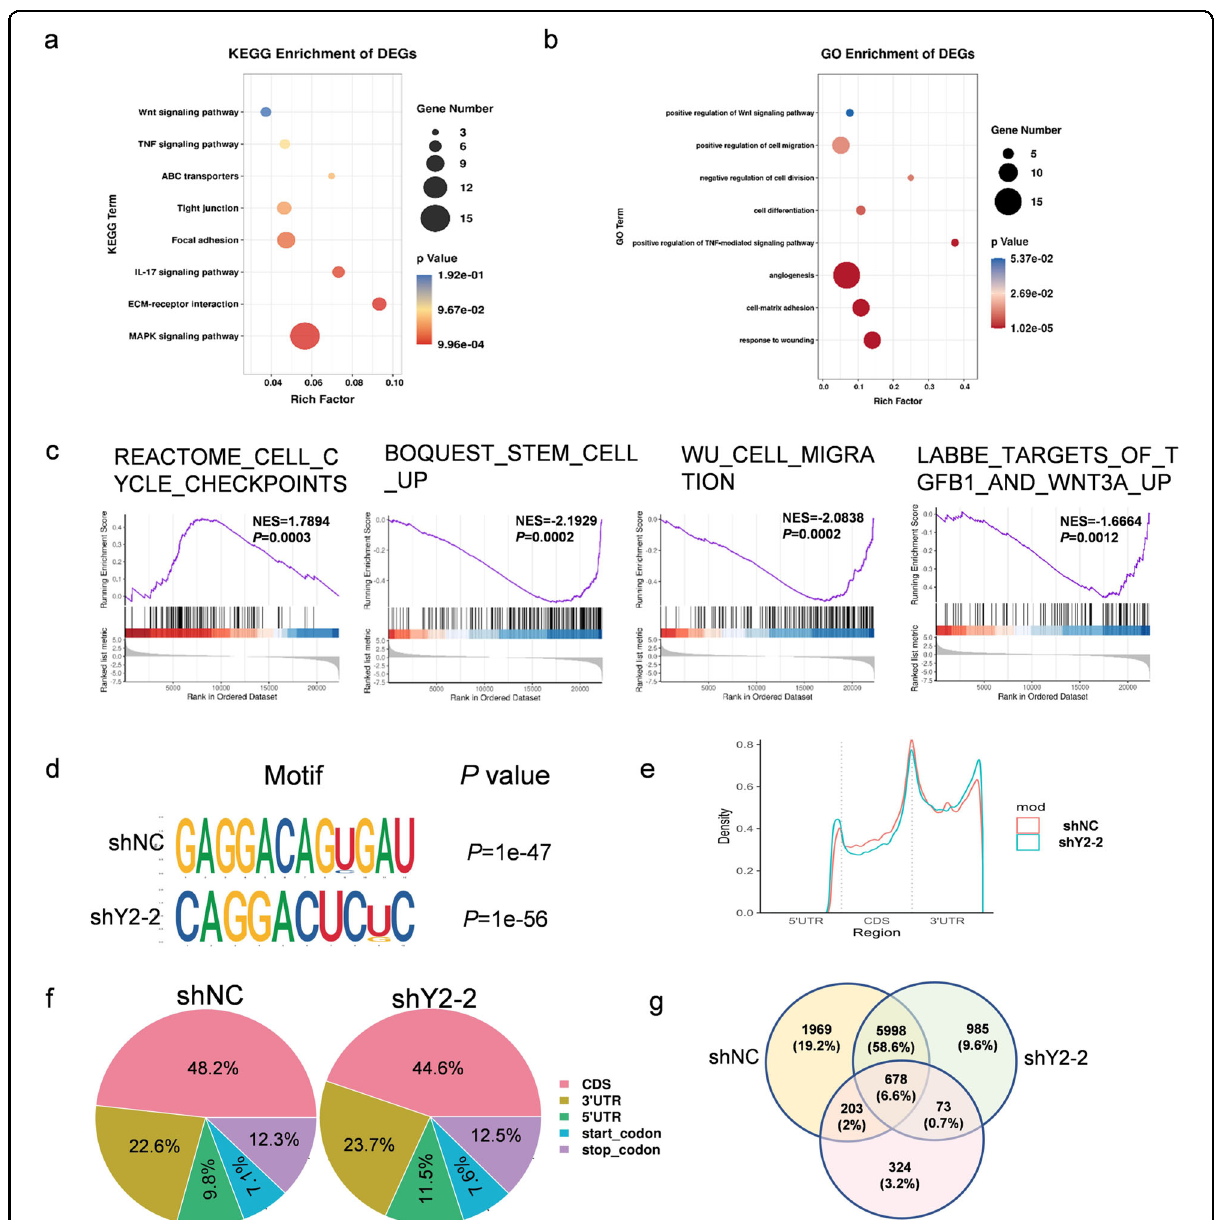
Fig. 4 Identi fi cation of YTHDF2 targets via MeRIP-seq and RNA-seq in LUAD. a , b KEGG and GO enrichment analysis of differentially expressed genes (DEGs) identi fi ed by RNA-seq. c GSEA plots showing that the pathways of DEGs altered by YTHDF2 knockdown were involved in LUAD. d m6A motif detected by the HOMER motif analysis with m6A-seq data in A549 cells with or without YTHDF2 knockdown. e Metagene pro fi les of m6A enrichment across the mRNA transcriptome in LUAD. f Graphs of m6A peak distribution showing the proportion of total m6A peaks in the indicated regions in control and YTHDF2-knockdown cells. g Venn diagram illustrating the overlapped targets of YTHDF2 in control and YTHDF2-knockdown cells identi fi ed by m6A-seq analysis and the targets identi fi ed by eCLIP and